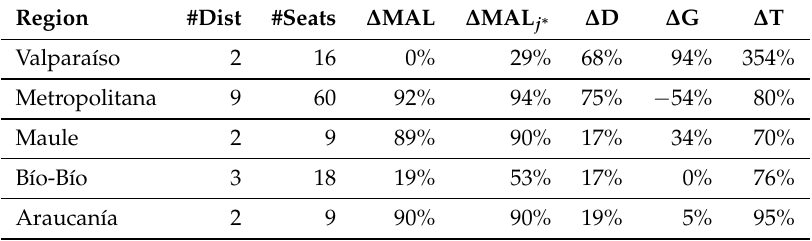
Table 4. Current system v/s Our method: Relative differences (in %) in the performance of the five criteria.